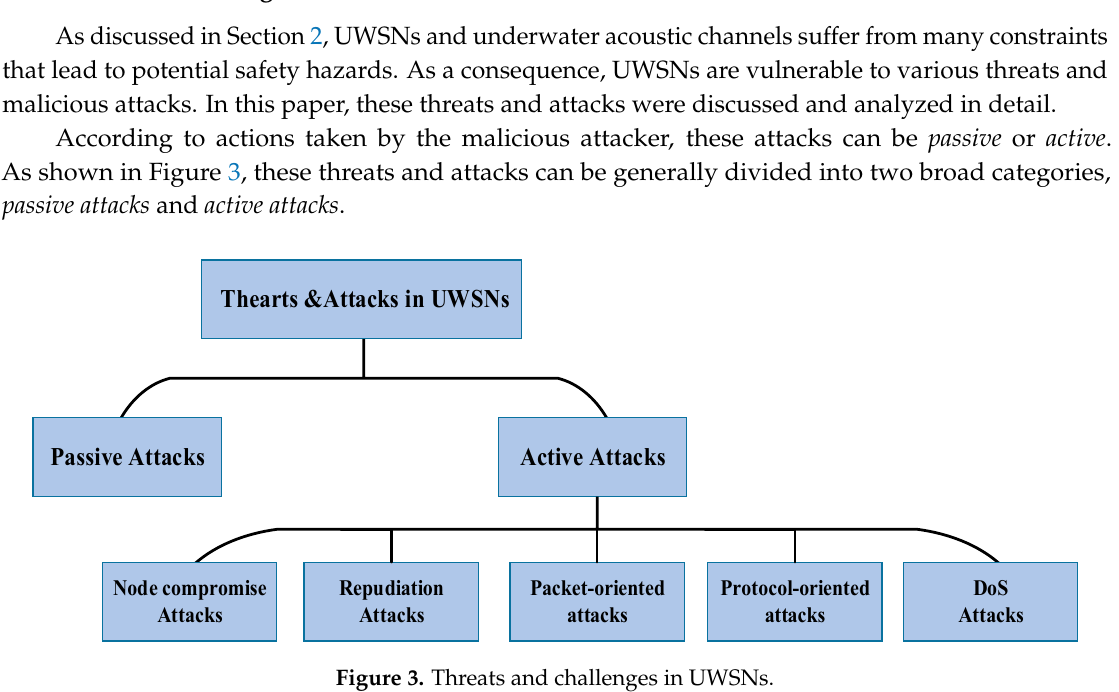
Figure 3. Threats and challenges in UWSNs.